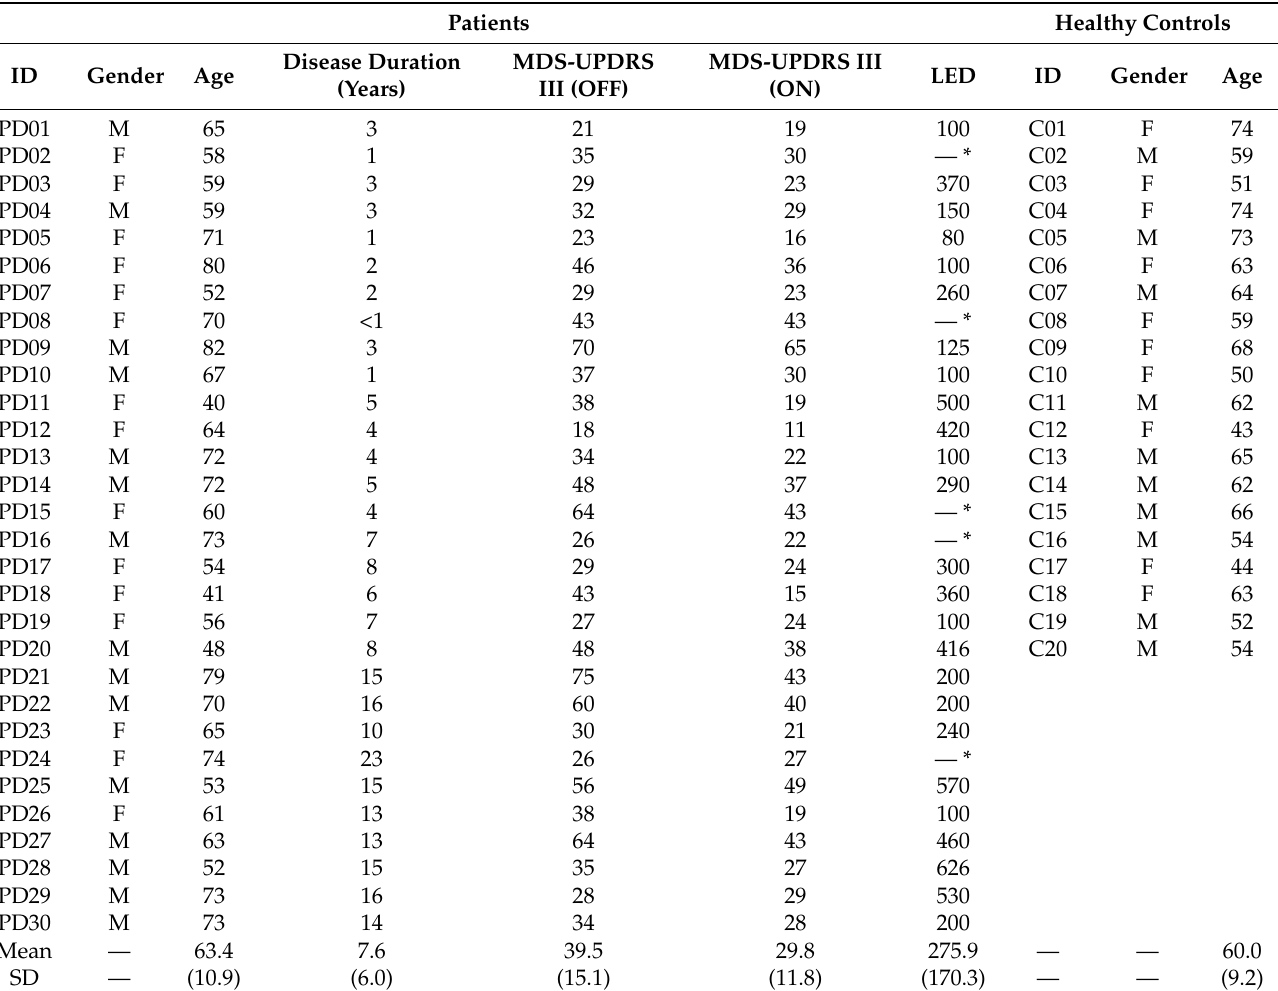
Table 1. Participants’ demographic characteristics. For patients, disease duration, MDS-UPDRS scores, and levodopa equivalent doses (LED) taken in the Med-ON condition are